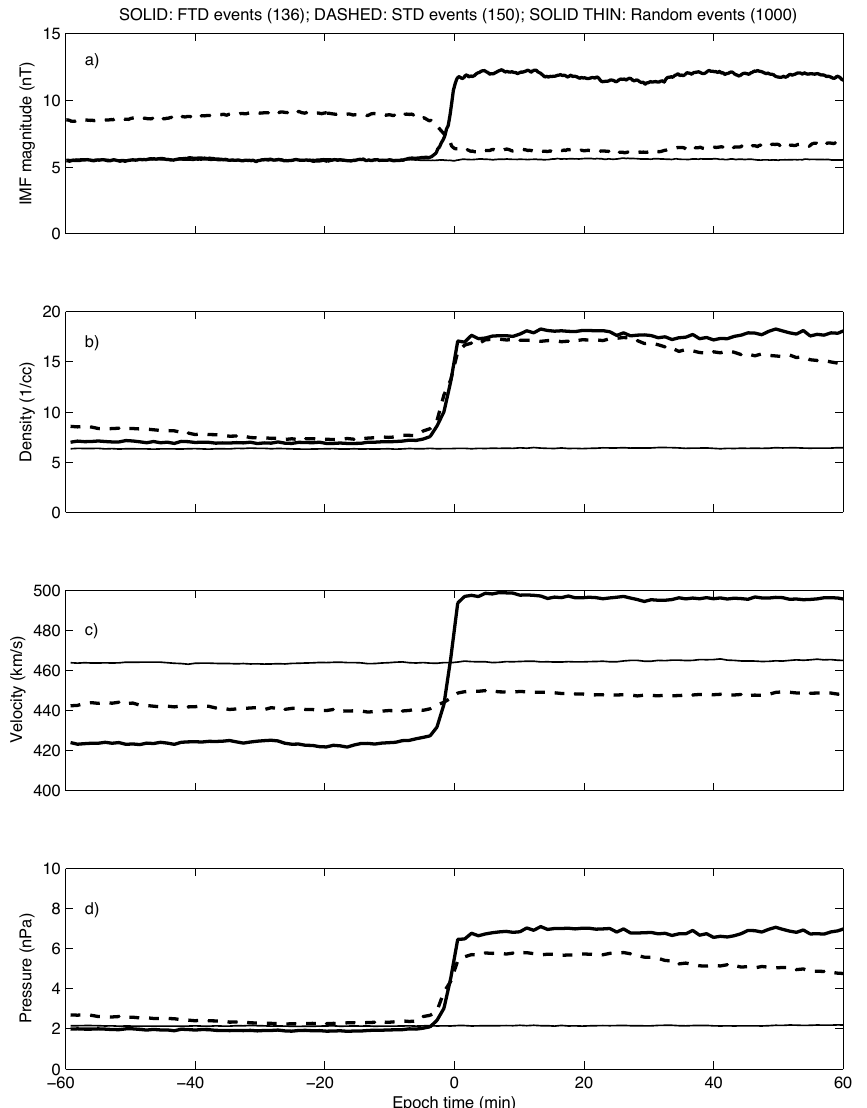
Fig. 1. Superposed epoch averages for the 136 fast type (solid) and 150 slow type (dashed) solar wind discontinuities during 1998–2004. Thin solid line is a superposed epoch average for 1000 random time periods. (a) IMF magnitude, (b) solar wind density, (c) solar wind velocity, and (d) solar wind dynamic